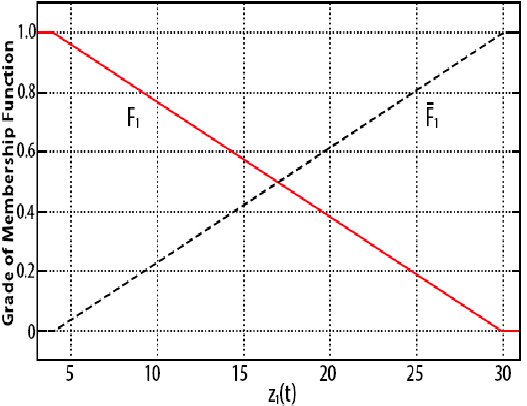
Figure 2. The membership functions of